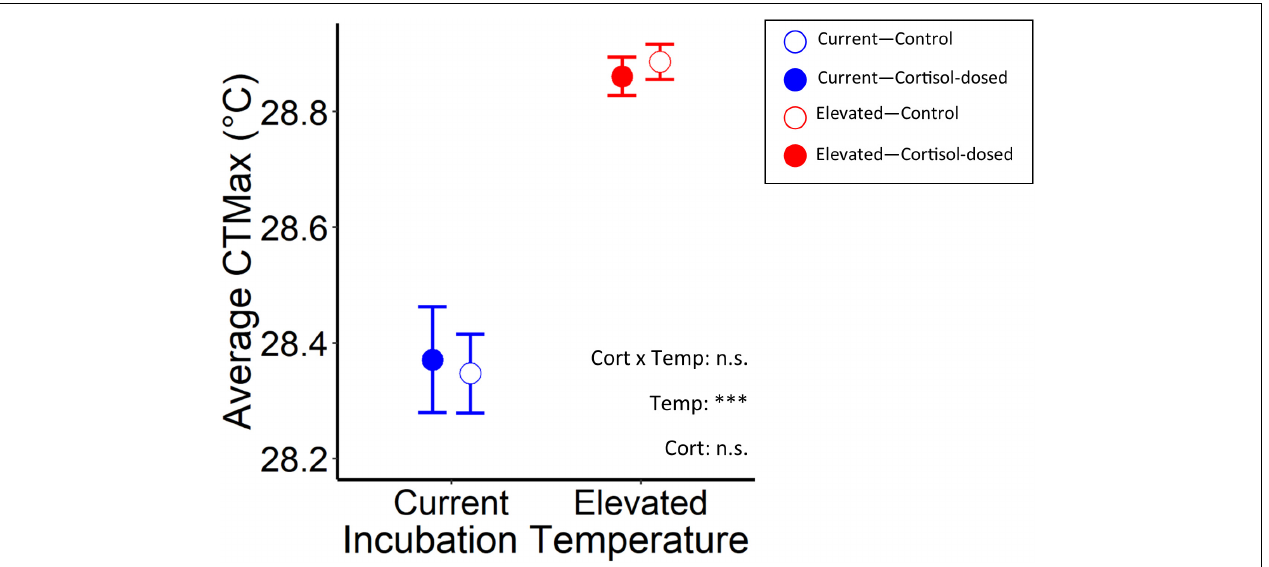
FIGURE 4 | Effects of rearing temperature and prenatal cortisol on average CT Max in juvenile Chinook salmon exposed to control (open circles) and cortisol-exposed (closed circles) treatments and raised in current (blue), or elevated (red) temperature regimes (n.s. and *** represent p -values that were > 0.05 and < 0.001,